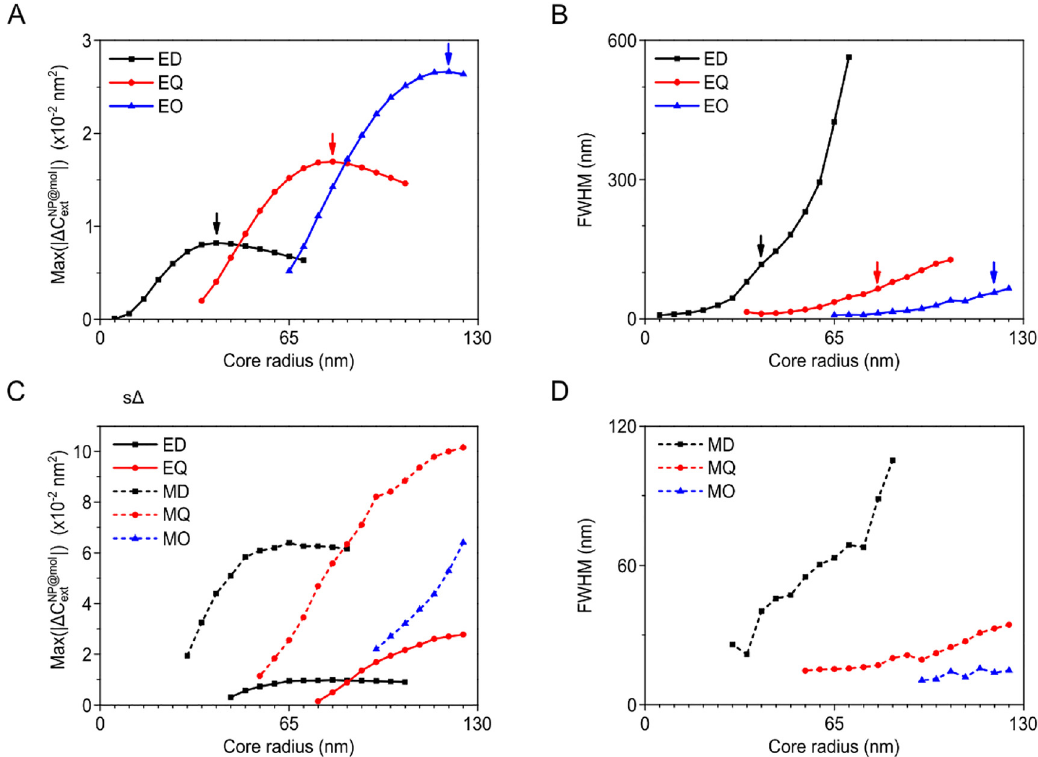
⃒⃒⃒⃒⃒ ⃒⃒⃒⃒⃒ Δ C NP @ mol and FWHM of each resonance for varied core radii. (A) And (B) show silver core-chiral shell Figure 4: The maximum value of ext nanoparticle, (C) and (D) show silicon core-chiral shell nanoparticle. In (A) and (B), the arrow denotes the core radius position at which the (⃒⃒⃒⃒⃒ ⃒⃒⃒⃒⃒) Δ C NP @ mol Max is maximized. In Figure 4D, the FWHM for electric resonances are not well de fi ned and thus not plotted. ext conclude that the magnetic resonances of high index dielectric nanoparticles induce larger CD signals with smaller CD linewidths than electric resonances or the res- onances of plasmonic nanoparticles. All these features are summarized in Table 1. Table  : Advantages of different multipole resonances for induced CD. X denotesthatthere are noinduced CD signals.The triangle and circle symbols indicate which resonant properties are more advan- tageous for obtaining the measurable induced CD signals ( △ ⟨ : ⟨ ○ ⟨ ● ). △ indicates small magnitudes and broad spectral line- shape CD signals. ● indicates large magnitudes and sharp spectral lineshape CD